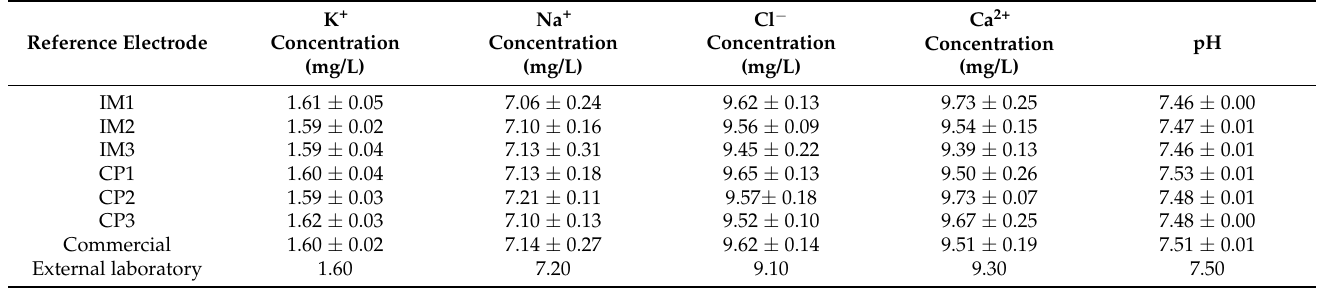
Table 3. Ion concentrations measured in RW1 at room temperature (22 ± 1 ◦ C) using SSC and commercial reference electrodes and compared with the results from routine laboratory analyses.